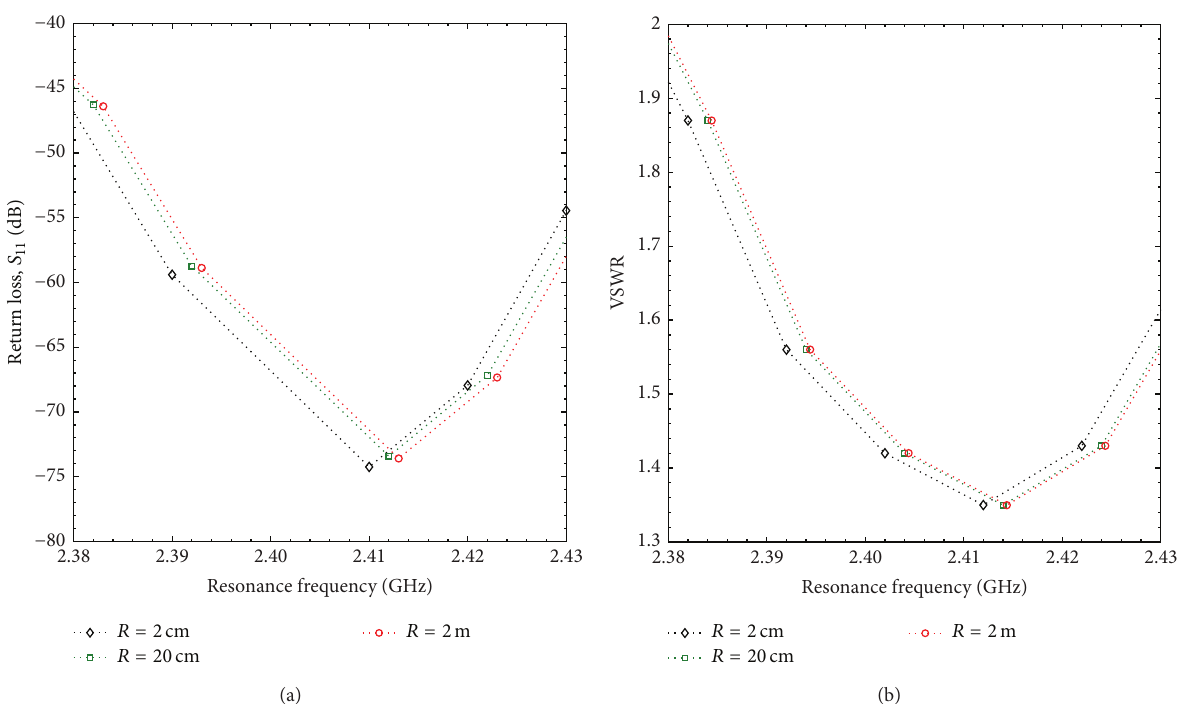
Figure 8: Impact of changing radius of curvature (2cm, 20 cm, and 2 m) of a circular microstrip patch (a) on the return loss in dB and (b) on the VSWR as a function of frequency. “Teflon substrate,